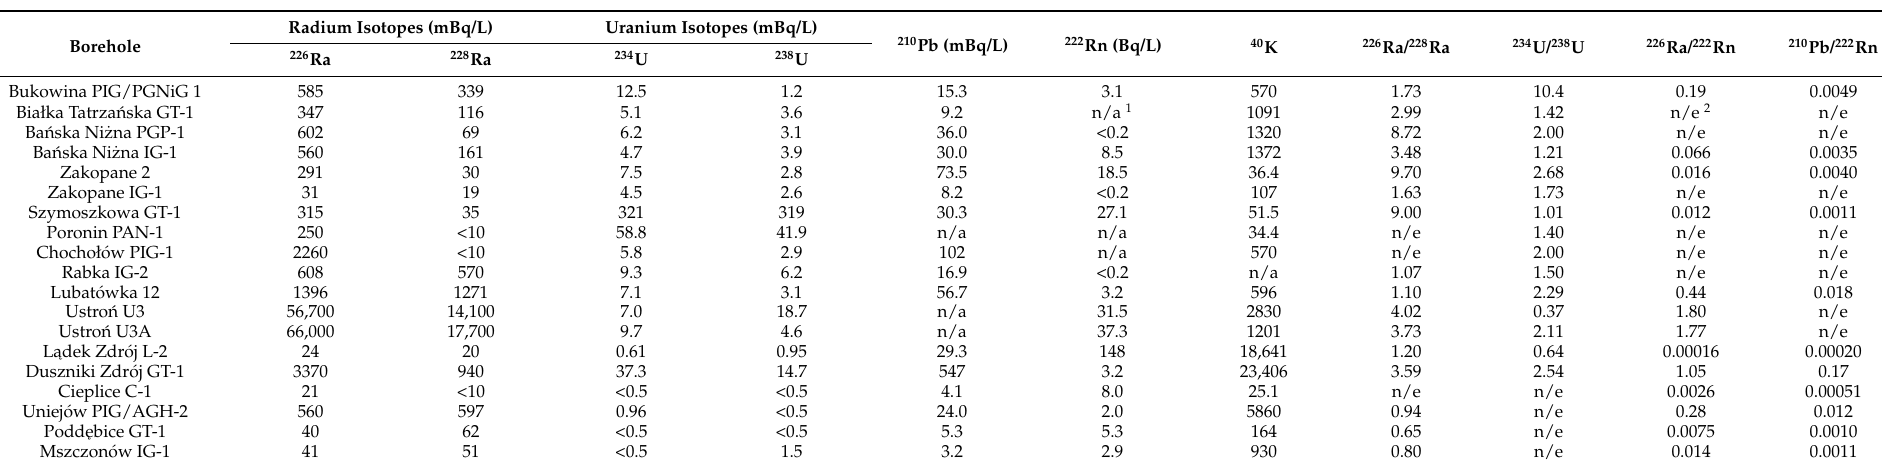
Table 2. The concentrations of radioactivity of 226, 228 Ra, 234, 238 U, 210 Pb, 222 Rn and 40 K in Polish thermal